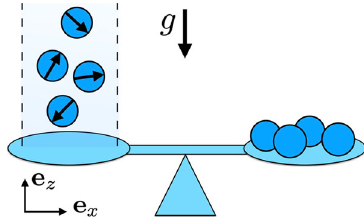
Fig. 5 Illustration of sedimentation of active Brownian particles under gravity g . The active particles with orientation ω (black arrows) are con fi ned by a lower wall and periodic boundary conditions on the sides (dashed lines). The total force that the swimming particles exert on the bottom wall (left scale pan) is equal to their weight (right scale pan) in steady states of